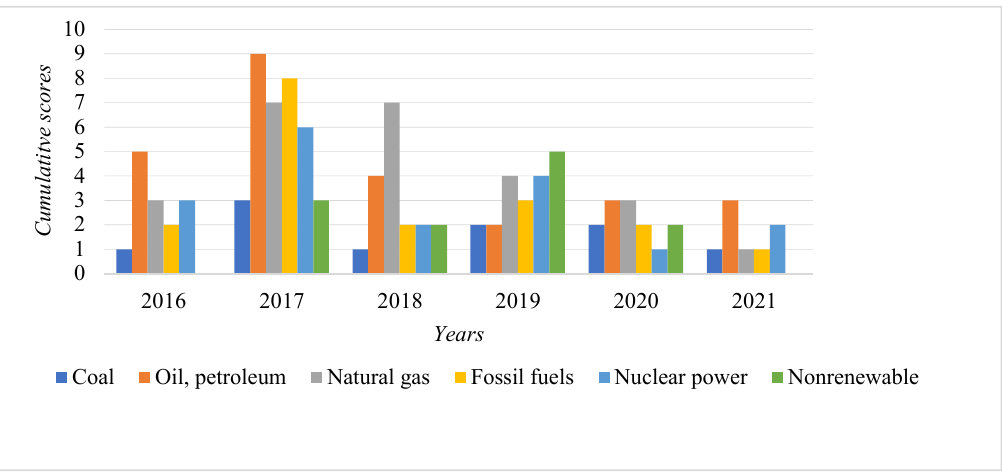
Figure 4. Publications on nonrenewable energy sources in the context of energy security education with polynomial trendlines.